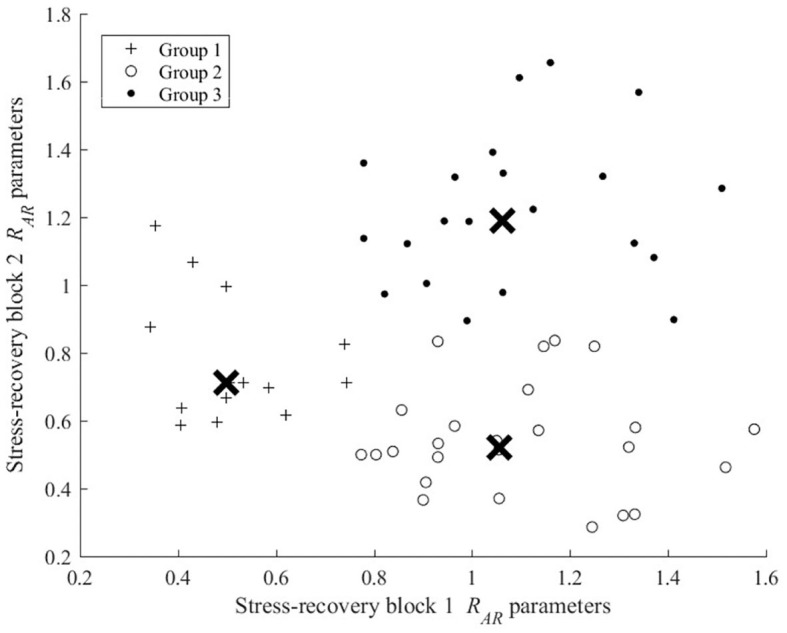
Dynamic resilience groups formed via K-means three clustering of RARk (k = 1, 2) scores. (X denotes group centroid).